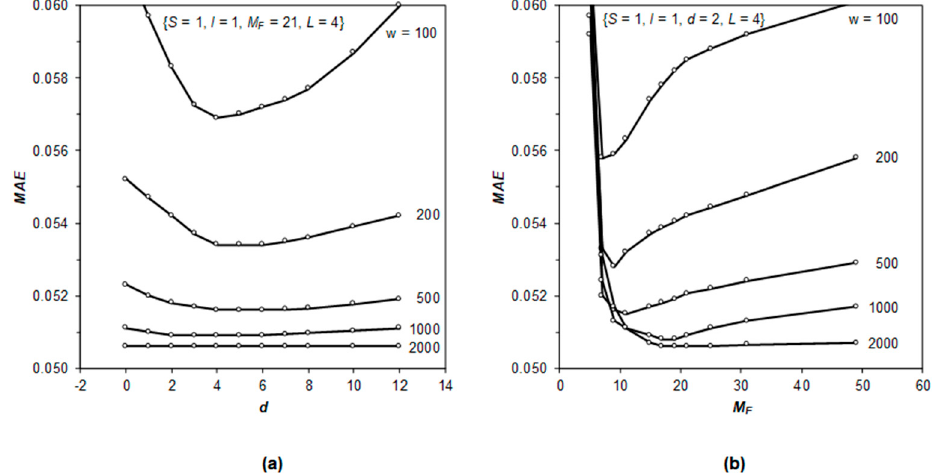
Figure 4. Effect of d , M F , and w on the mean absolute error (MAE) for L = 4: ( a ) Penalty for model complexity, d , and ( b ) maximum number of functions in the forward phase, M F . Each single point in a curve comprises 8000 evaluations of the model, from t = 2000 to t = 10,000.